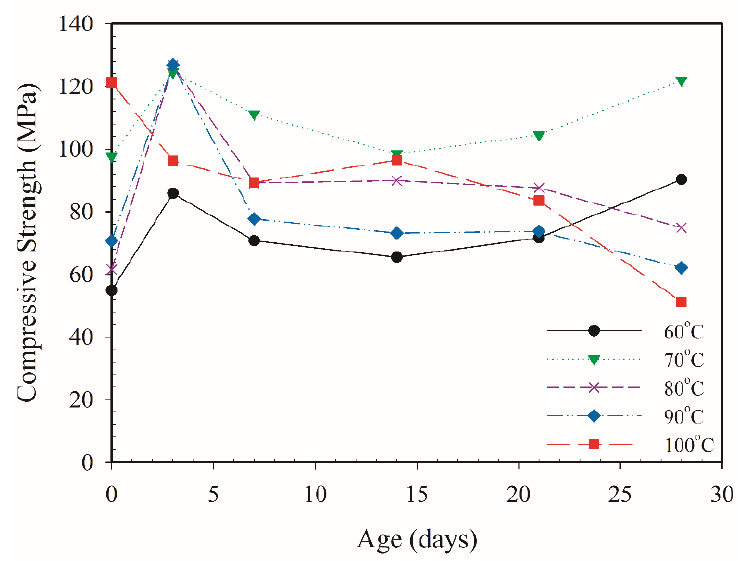
Figure 9. Changes in compressive strength with standing time in air under various curing temper- atures after 24-h curing when AE% = 3%.